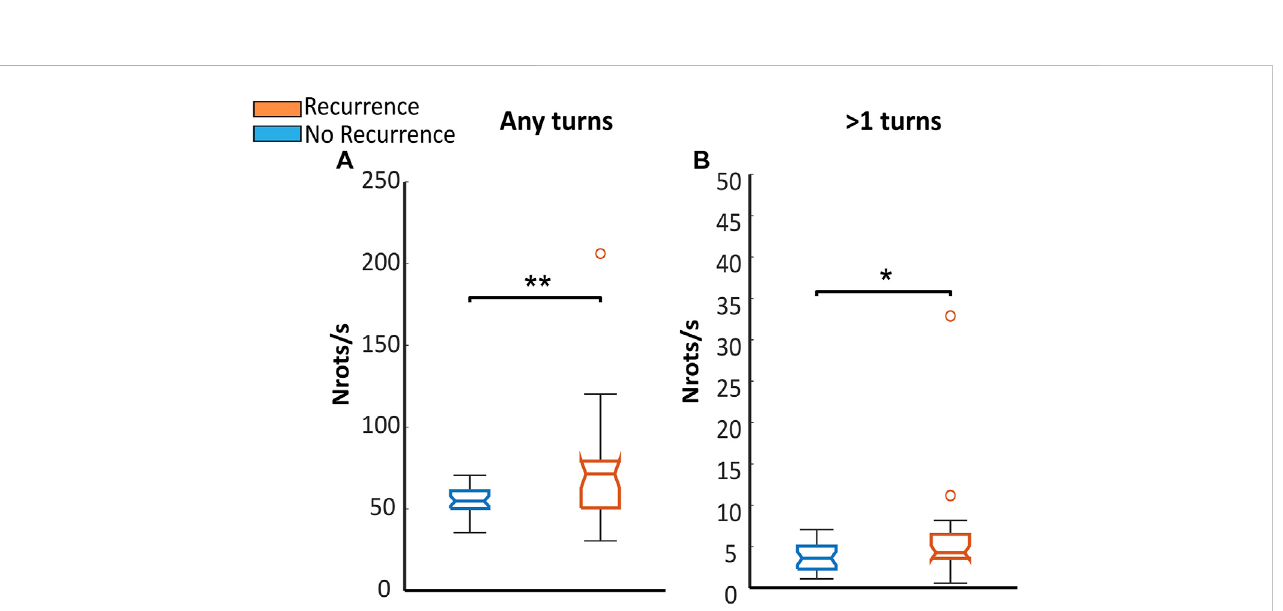
Numberofrotorsobtained inallthepatients:Inbluearerepresentedpatientsstayinginsinusrhythm(Norecurrence) andinorangepatientsreturningto arrhythmia 6 months after PVI (Recurrence). The number of rotors was calculated in the whole atria in two different scenarios regarding the number of turns used to fi lter the PS: (A) Number of rotors obtained without any turn fi ltering; (B) Number of rotors spinning for at least one